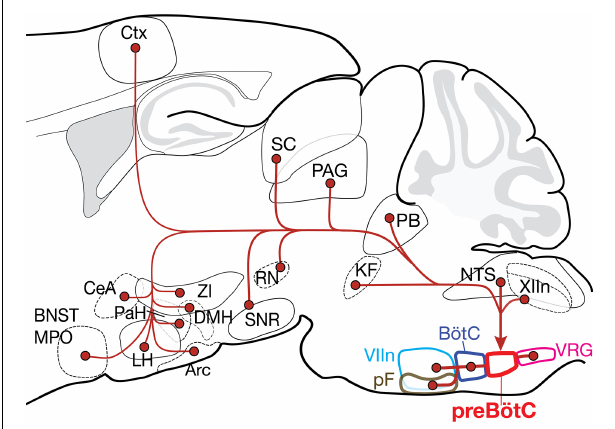
FIGURE 5 | Summary of the projection profiles of SST + and GlyT2 + preBötC neurons. Projections from higher order brain regions may provide volitional and emotional control of breathing. Arc, arcuate nucleus; BNST, bed nucleus of the stria terminalis; BötC, Bötzinger complex; CeA, central amygdala; Ctx, cortex; DMH, dorsomedial hypothalamus; KF, Kölliker-Fuse; LH, lateral hypothalamus; MPO, medial preoptic area; NTS, nucleus of the solitary tract; PAG, periaqueductal gray; PaH, paraventricular hypothalamus; PB, parabrachial nuclei; pF, parafacial nuclei; RN, red nucleus; SC, superior colliculus; SNR, substantia nigra; VIIn, facial nucleus; VRG, ventral respiratory group; XIIn, hypoglossal nucleus; and ZI, zona